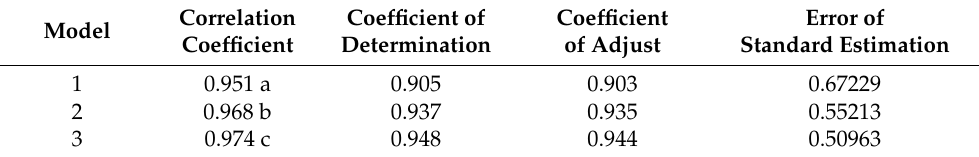
Table 3. Regression model output results.